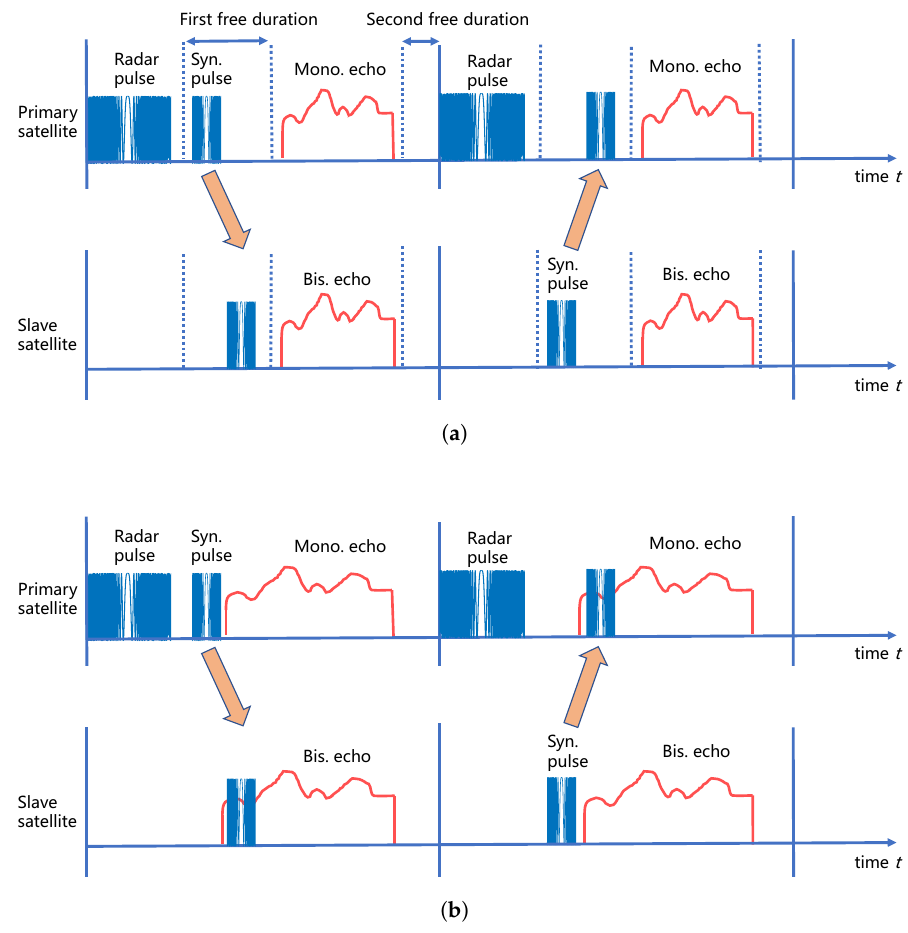
Figure 5. ( a ) Timing diagram of phase synchronization scheme proposed in [23]. ( b ) Timing diagram of proposed phase synchronization